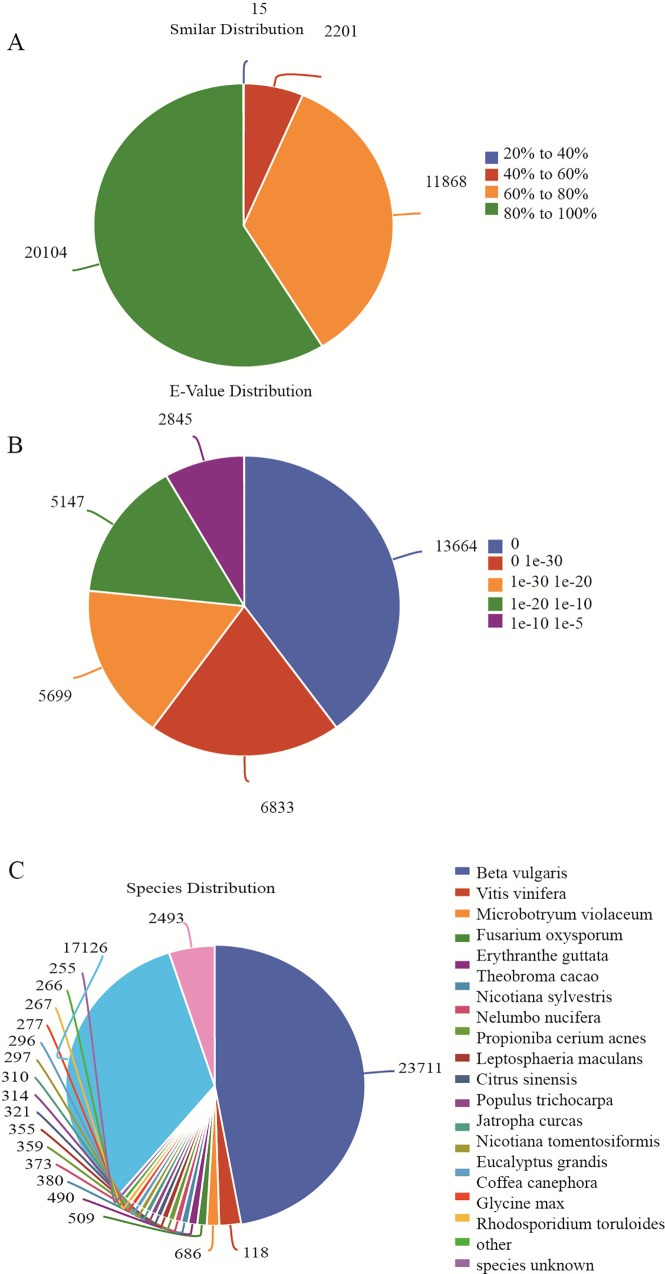
Species distribution of unigenes from P. heterophylla.a: Similarity distribution of top BLAST hits for each unigene; b: E-value distribution of BLAST hits with a cut off E-value of 1.0E−5; c: Species distribution for top BLAST hits in the Nr database.